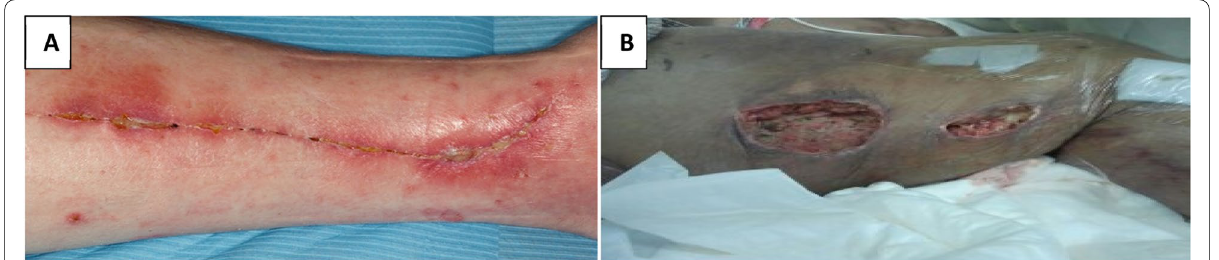
Fig. 1 Different presentations of leg wounds ( A ) erythema and superficial gapping ( B ) gapped wound in the